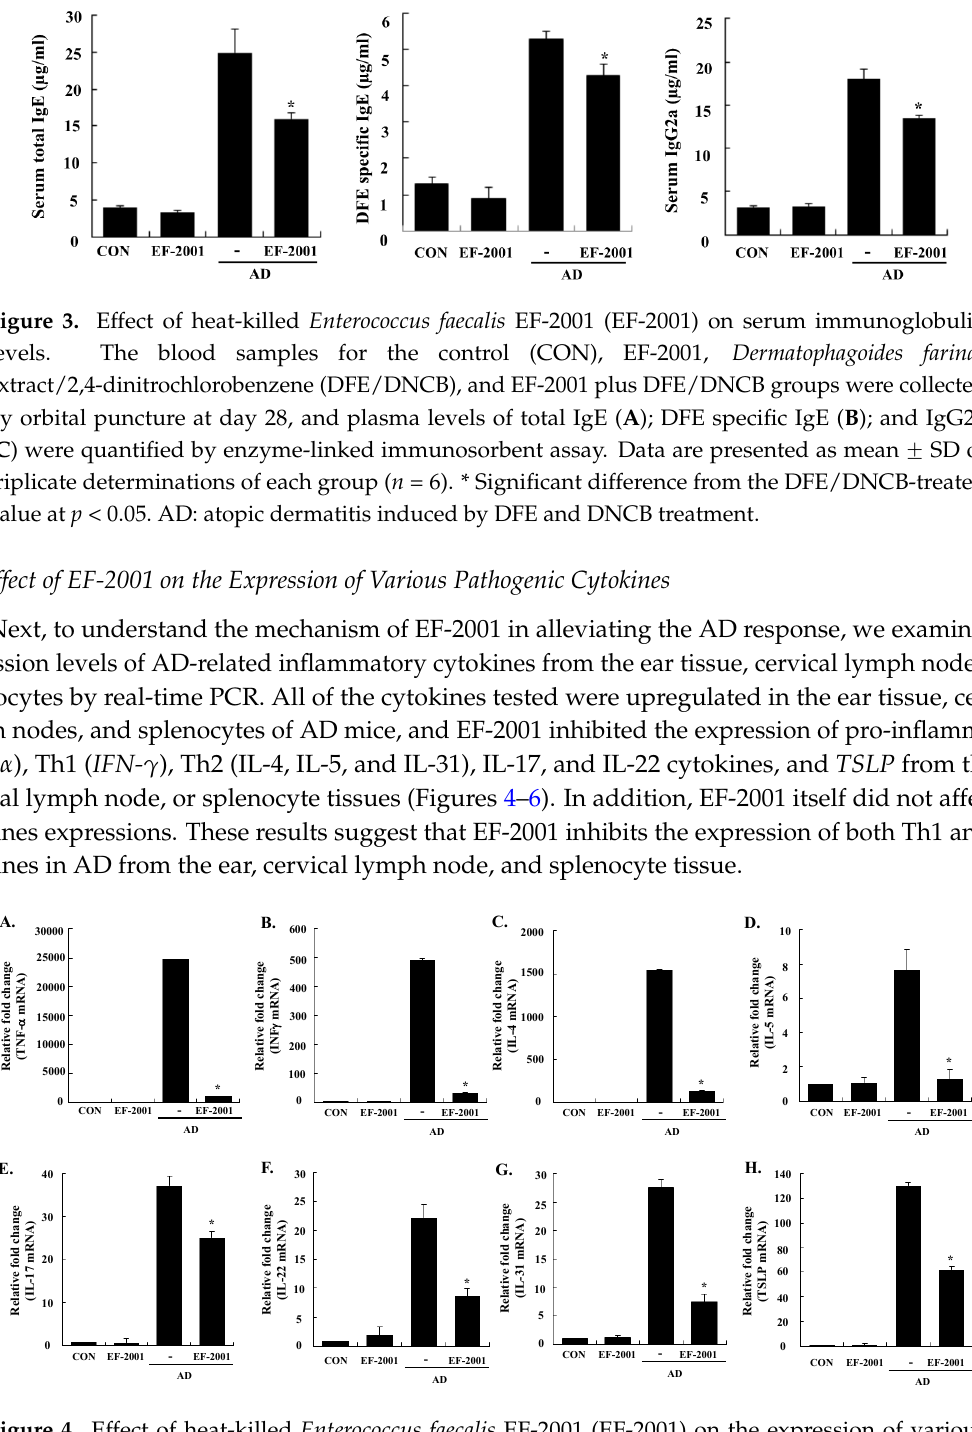
Figure 4. Effect of heat-killed Enterococcus faecalis EF-2001 (EF-2001) on the expression of various pathogenic factors in the ear. A , TNF- α ; B , INF- γ ; C , IL-4; D , IL-5; E , IL-17; F , IL-22; G , IL-31; H , TSLP. The ears were excised on day 28 and total RNA was isolated. Quantitative real-time polymerase chain reaction was performed as described in the Methods. Data are presented as mean ± SD of triplicate determinations of each group ( n = 6). * Significant differences from the DFE/DNCB-treated value at p < 0.05. DFE, Dermatophagoides farinae extract; DNCB, 2,4-dinitrochlorobenzene; AD: atopic dermatitis induced by DFE and DNCB treatment.